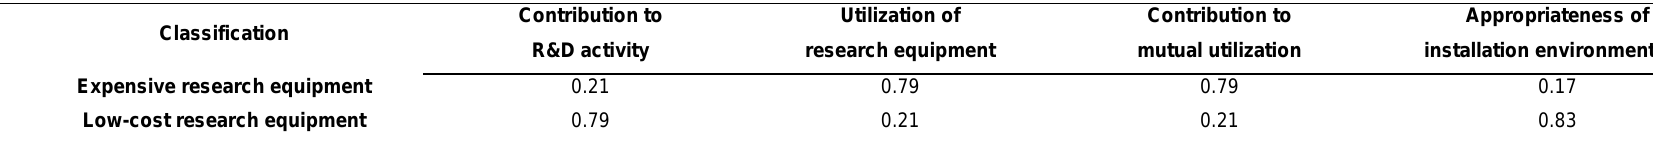
Table 13. Elements of the evaluation criteria